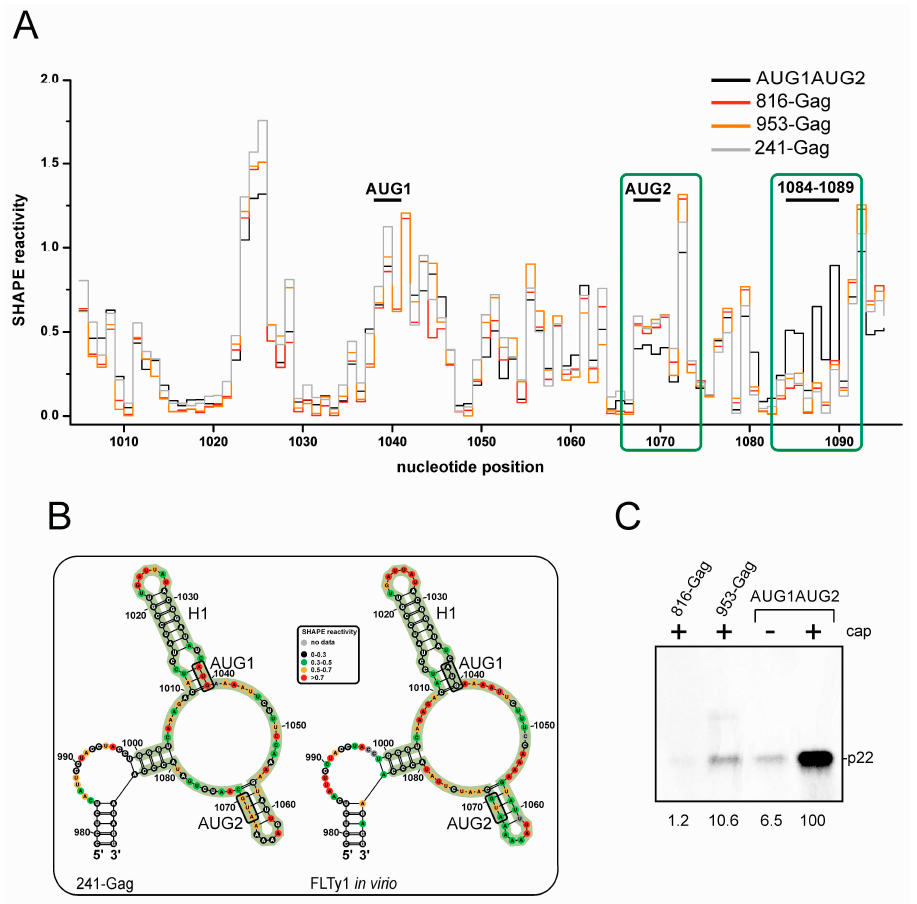
Figure 6. Secondary structure probing and the in vitro translation of 241-Gag RNA and its derivatives. ( A ) Reactivity plot of nucleotides spanning domain I in AUG1AUG2 RNA (black), 816-Gag RNA (red), 953-Gag RNA (orange) and 241-Gag RNA (grey). Regions showing consistent differences in reactivity are boxed (green). ( B ) Comparison of the secondary structure models of domain I obtained in vitro for 241-Gag RNA (left) and full-length genomic Ty1 RNA within virus-like particles (VLPs) (in virio conditions; right). Nucleotides that cover domain I in Ty1i RNA are marked (green background). p22 initiation codons and the H1 hairpin are also highlighted. ( C ) In vitro translation of sequential variants of Ty1 genomic RNA. Capped or uncapped transcripts were translated in wheat germ extract in the presence of the 35 S-methionine. Quantitation of the translation products is shown below the